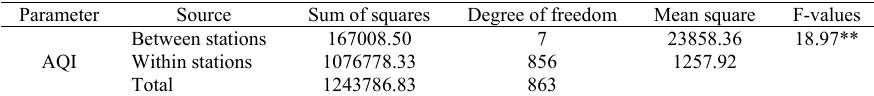
Table 10: One-way ANOVA test for AQI based on stations